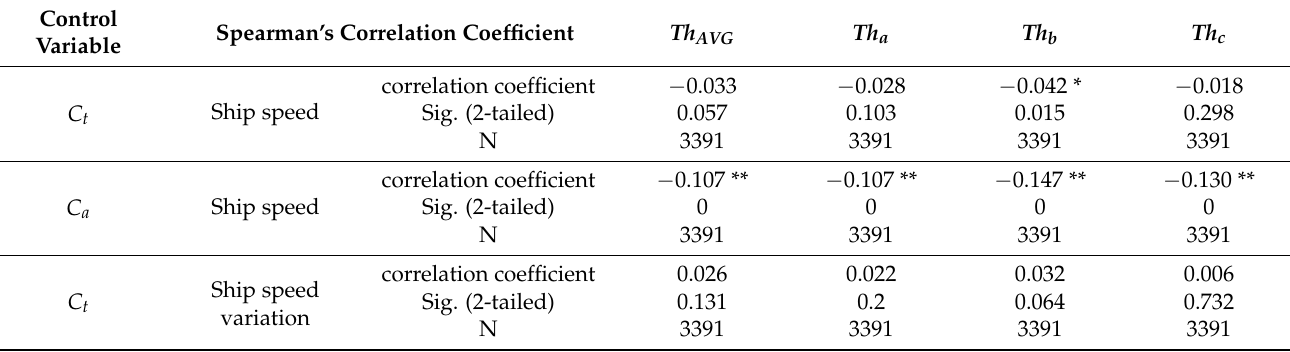
Table 8. Partial correlation analysis between sea ice conditions and ship movement characteristics with the control variable of ice